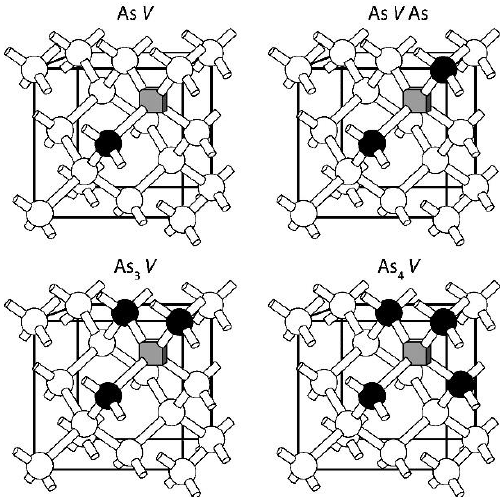
Figure 1. A schematic of the arsenic-vacancy (As n V ) defect clusters in Ge. Black circles represent the As atoms, white circles the Ge atoms, and cubes the vacancies [4].